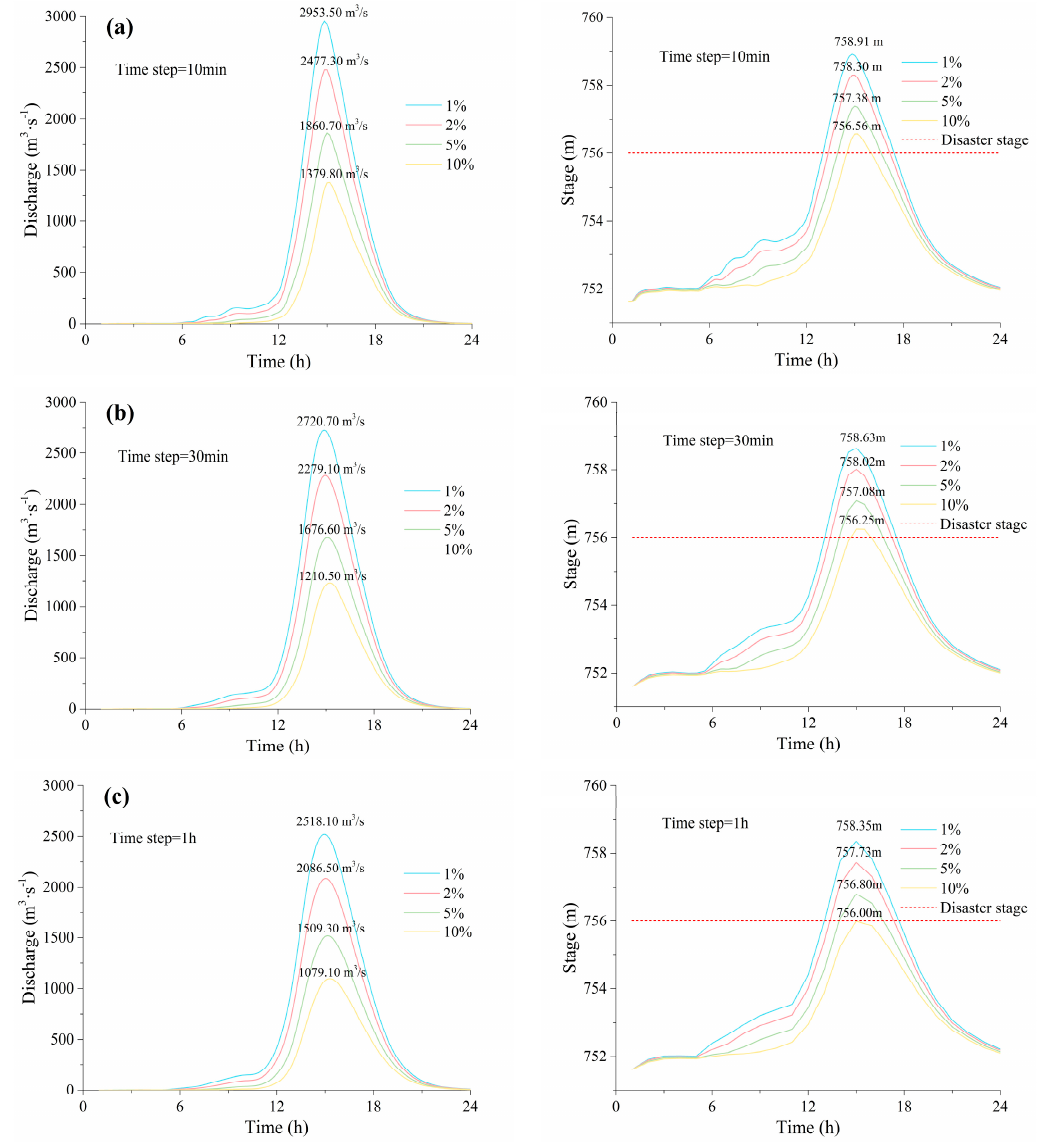
Figure 7. The simulated results of flood hydrographs with three computation time steps (10 min ( a ), 30 min ( b ), and 1 h ( c )) based on four frequencies of designed rainfall (1%, 2%, 5%, and 10%).